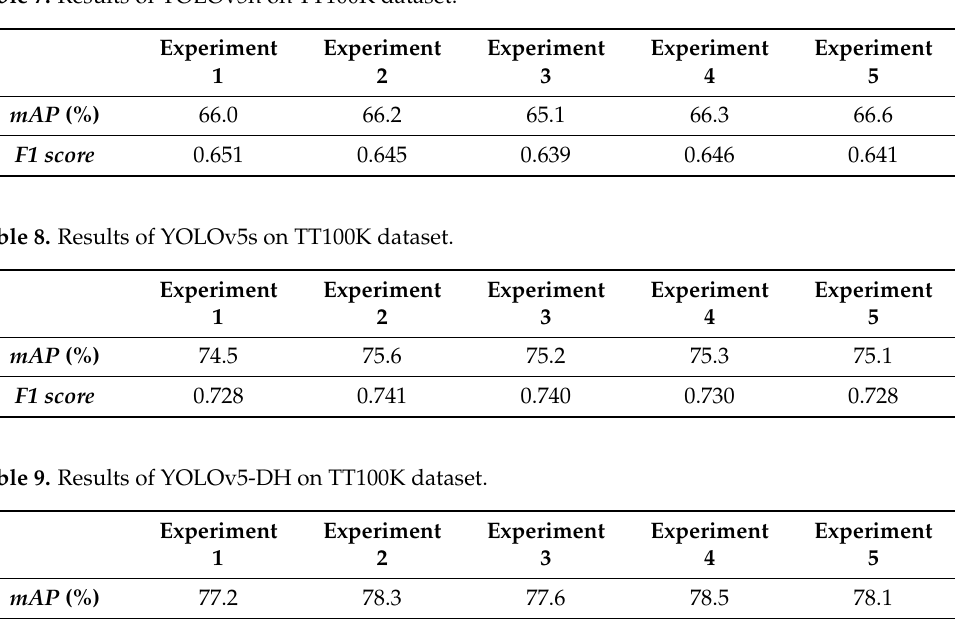
Table 7. Results of YOLOv5n on TT100K dataset.